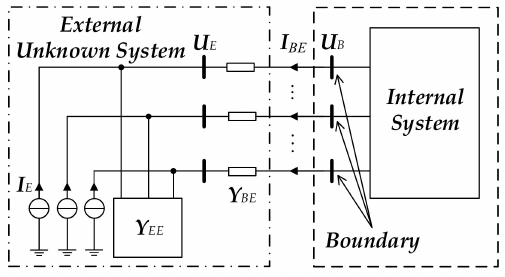
Figure 1. Multi-port Norton equivalent